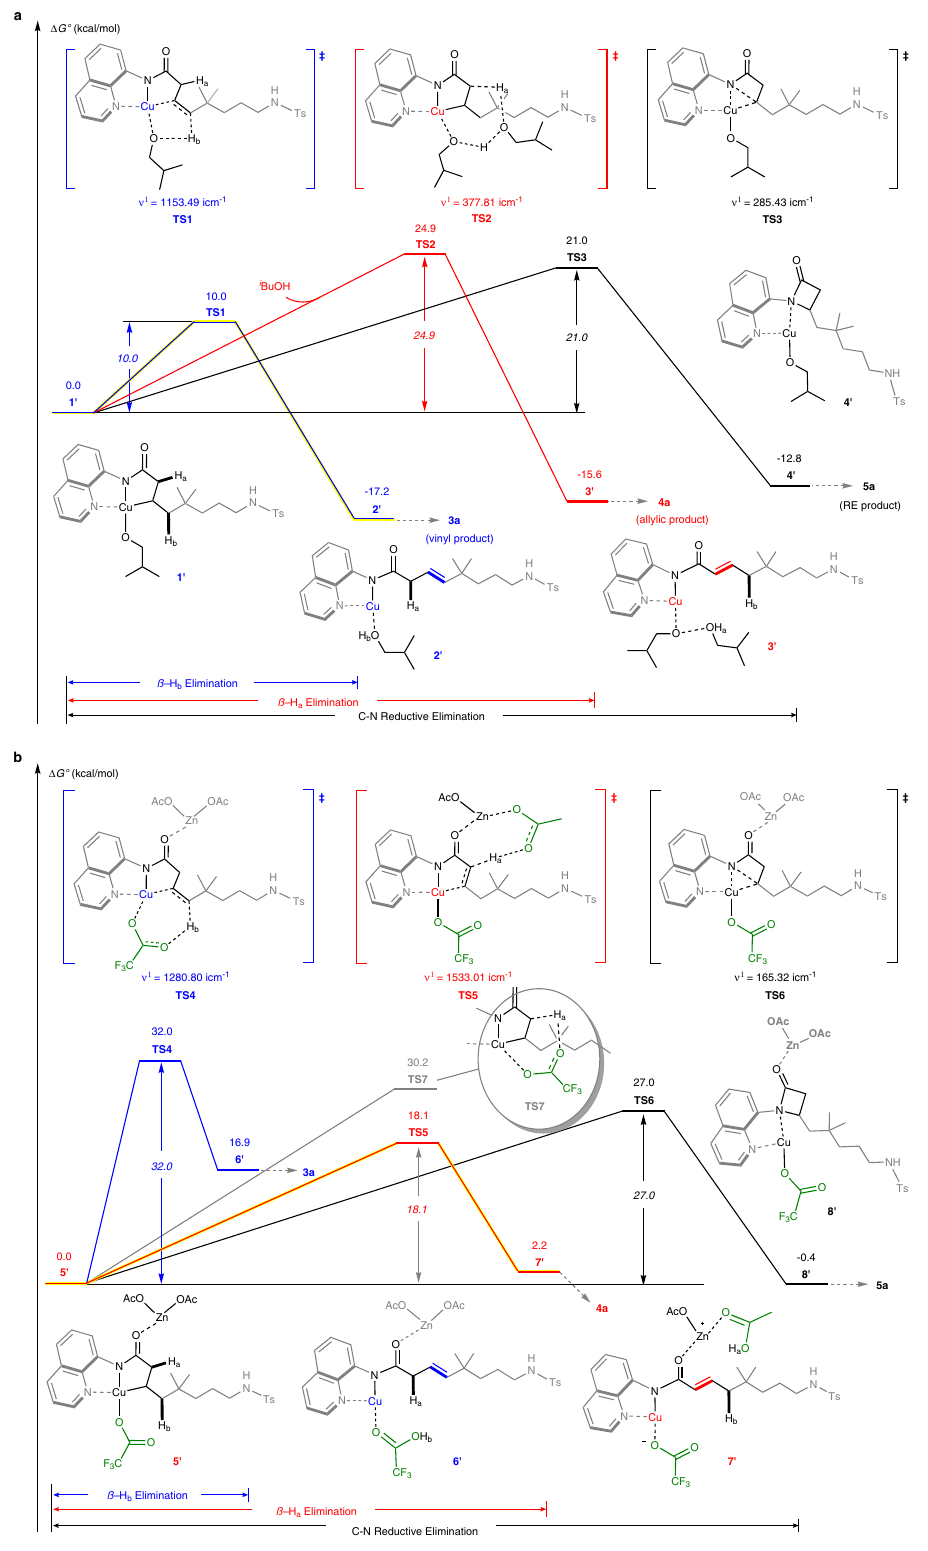
Fig. 9 | Gibbs energy pro fi les ( Δ G °) of three possible reaction pathways calcu- lated at the SMD( i BuOH/benzene)/(U)M06/[6-311++G(d,p)/SDD(Cu)]//SMD( i- BuOH/benzene)/(U)M06/[6-31G(d)/ LanL2DZ(Cu)] level. a Conditions A: